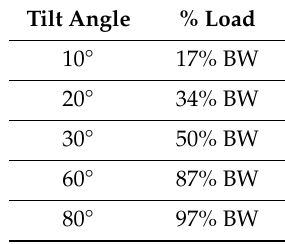
Table 3. Static loading as percentage of body weight (BW) depending on tilt